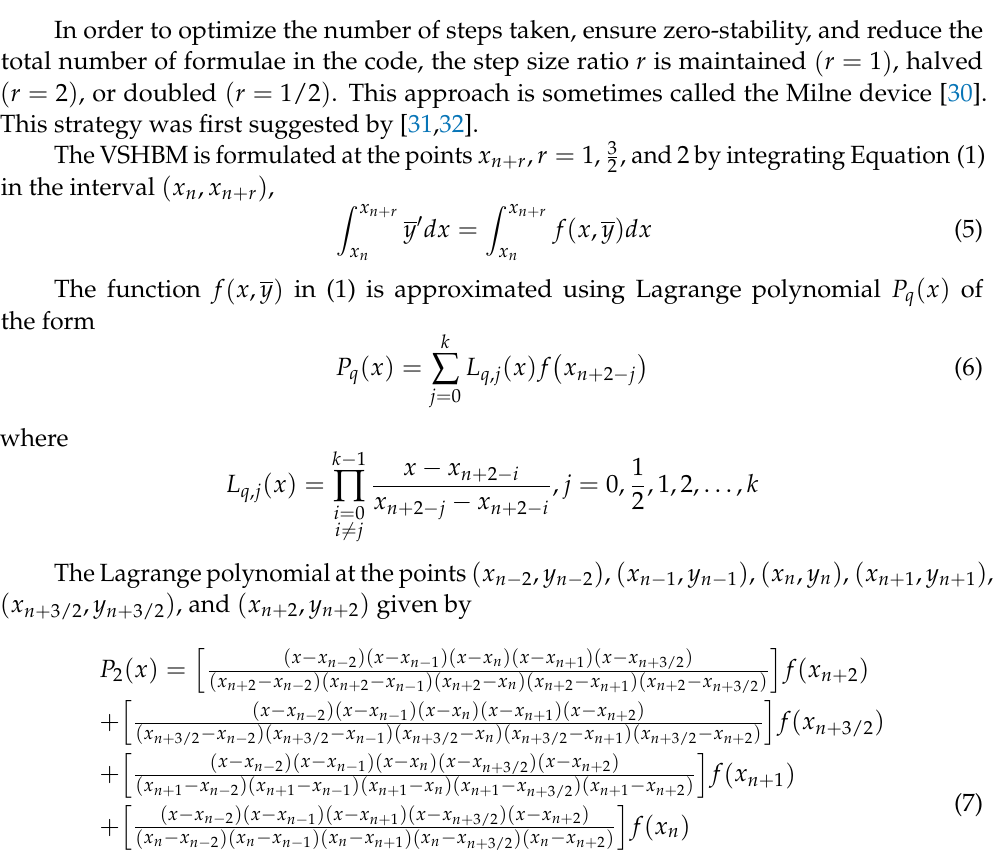
Figure 1. VSHBM showing interpolation points.